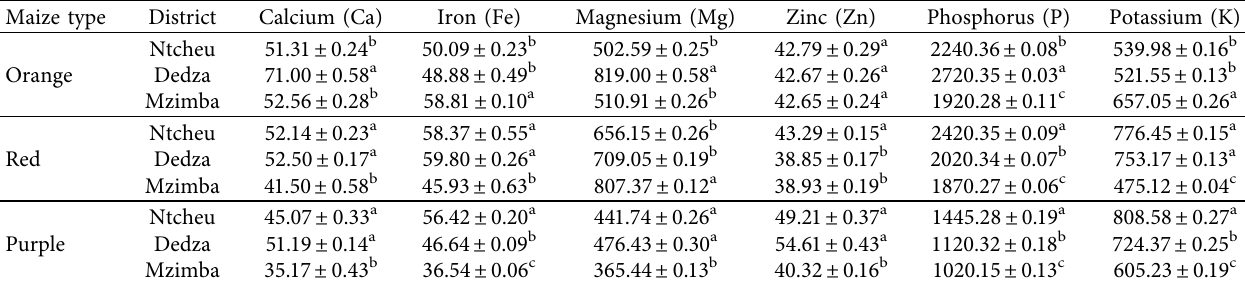
Table 2: Mineral content (mg · kg − 1 dry weight basis) of whole grain